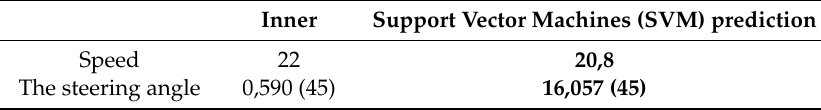
Table 5. Prediction of speed and steering angle inner